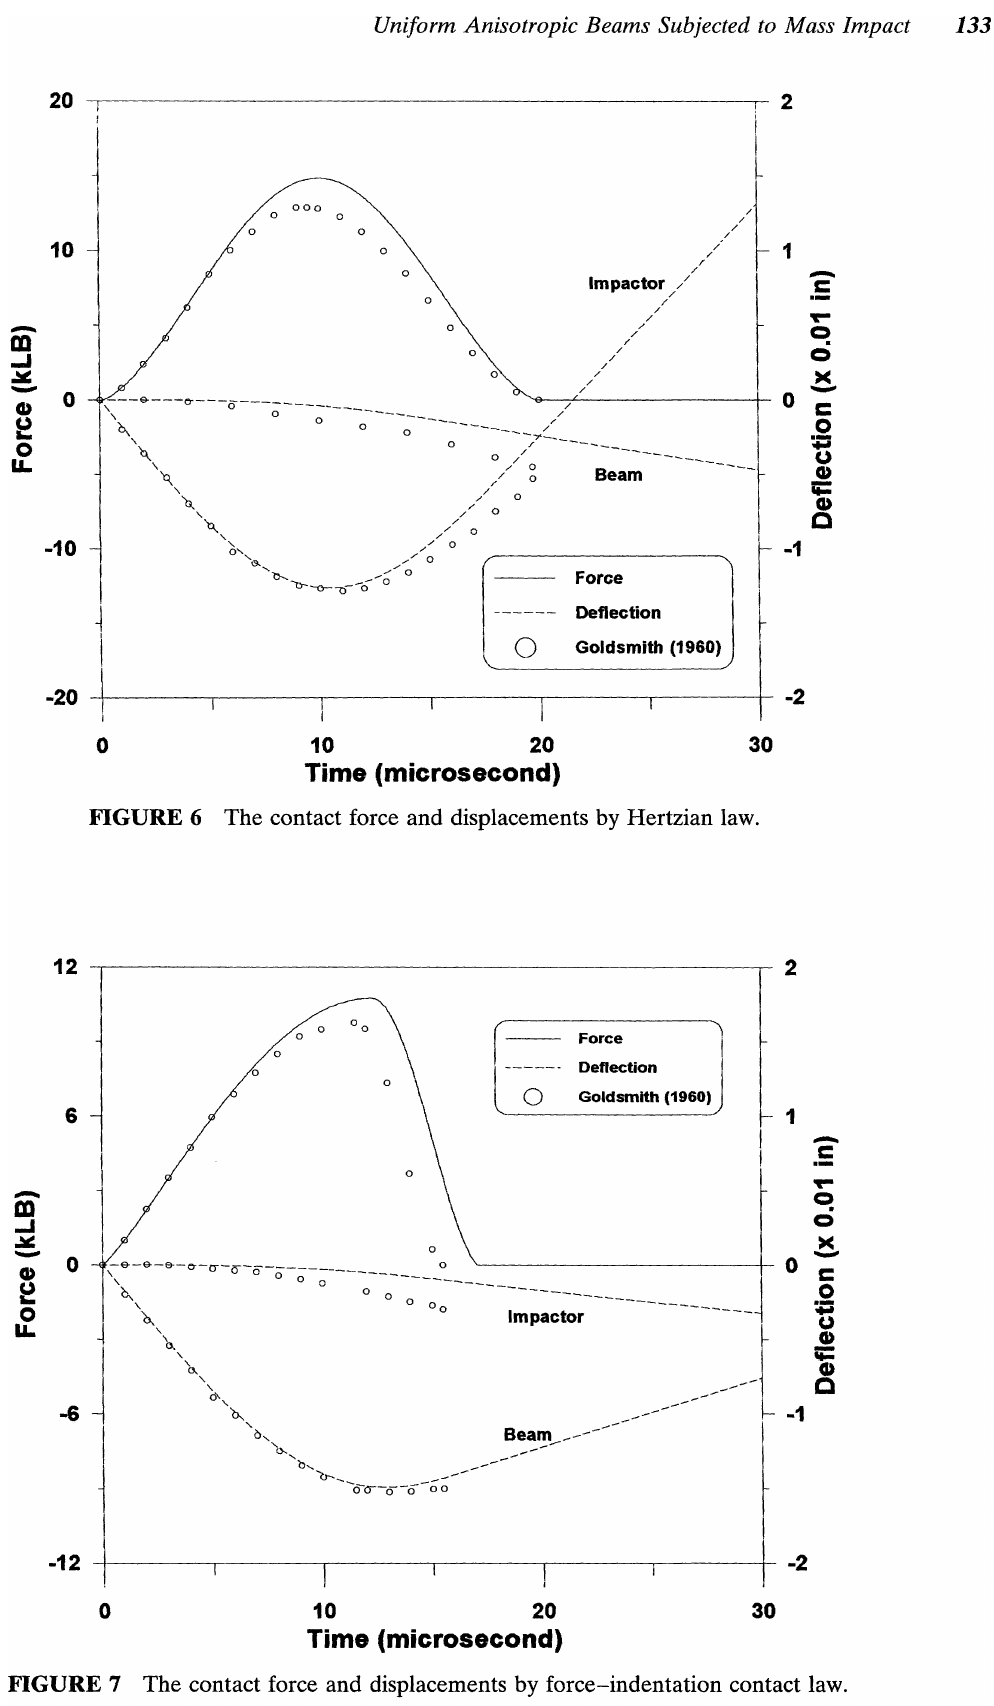
FIGURE 7 The contact force and displacements by force-indentation contact